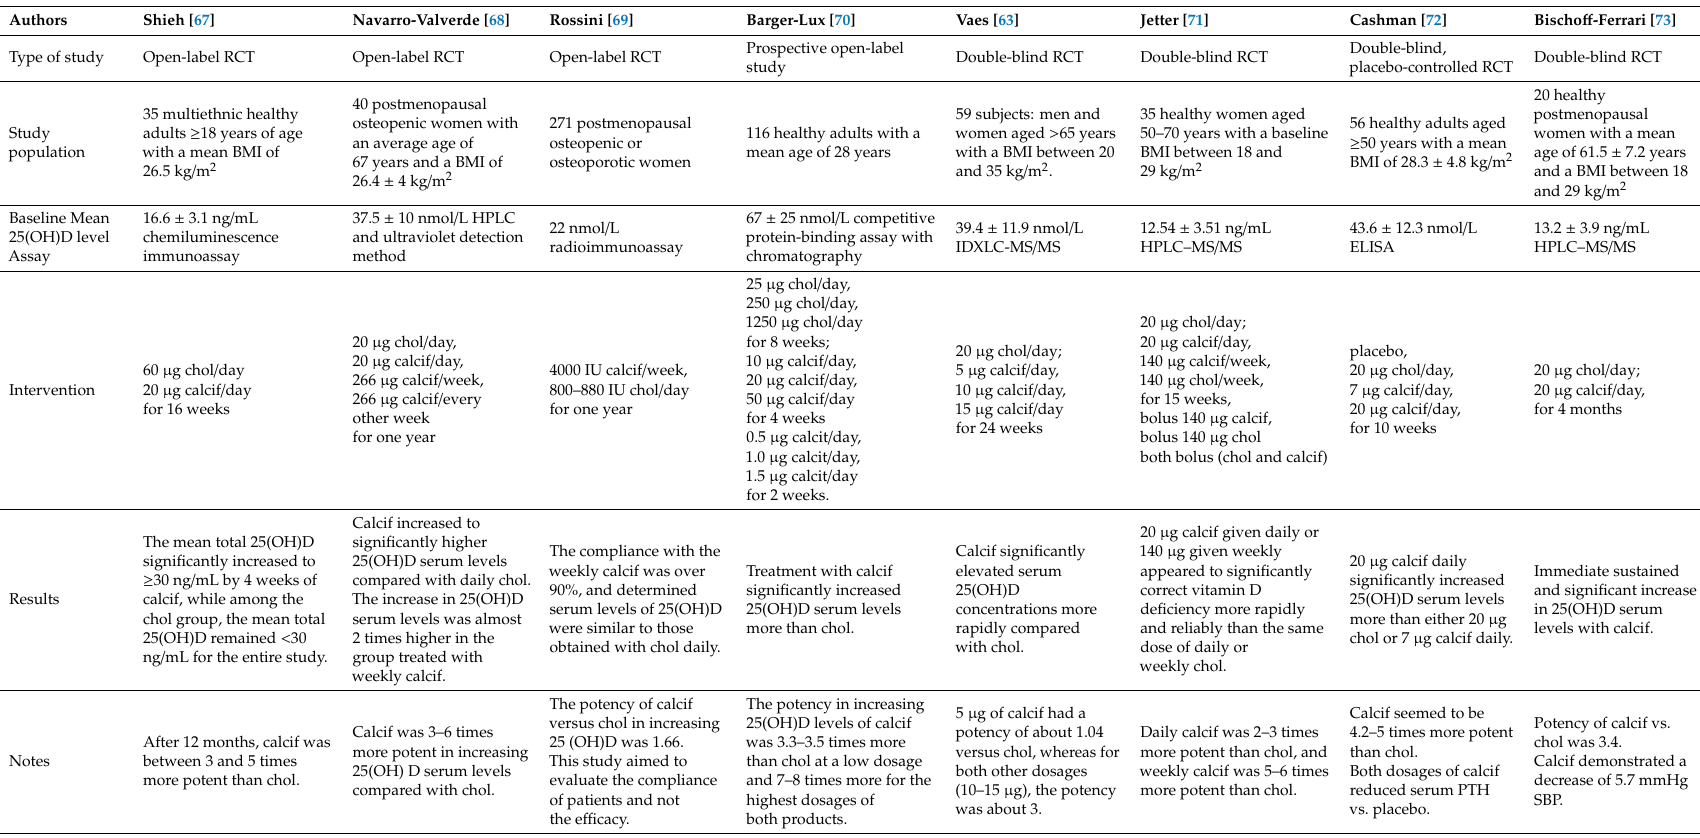
Table 1. Studies focused on the comparison between calcifediol and